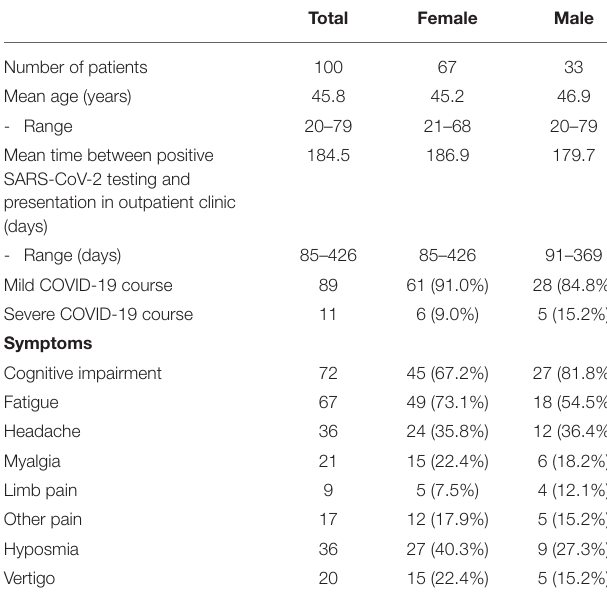
TABLE 1 | Characteristics of patients presenting to the neurological Post-COVID-19 outpatient clinic.